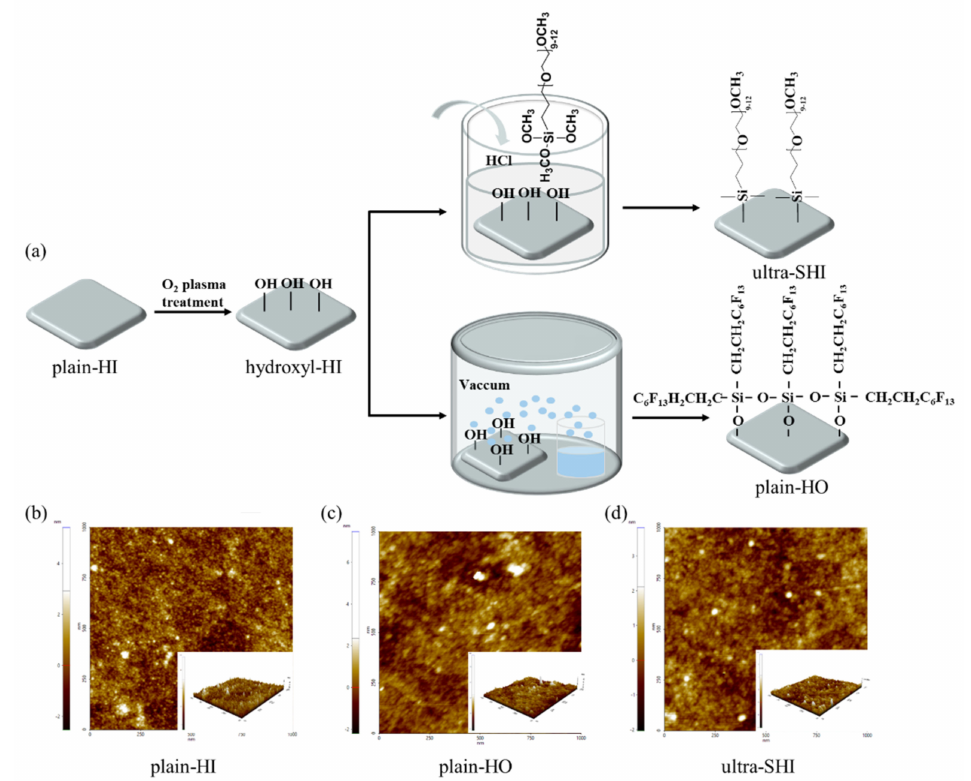
Figure 1. Fabrication and characterization of test surfaces. ( a ) Fabrication processes for the plain hy- drophilic (plain-HI) surface, the hydroxylated hydrophilic (hydroxyl-HI) surface, the plain hydropho- bic (plain-HO) surface, and the ultra-slippery hydrophilic (ultra-SHI) surface. AFM images showing the surface roughness of the ( b ) plain-HI surface, ( c ) plain-HO surface, and ( d ) ultra − SHI surface.